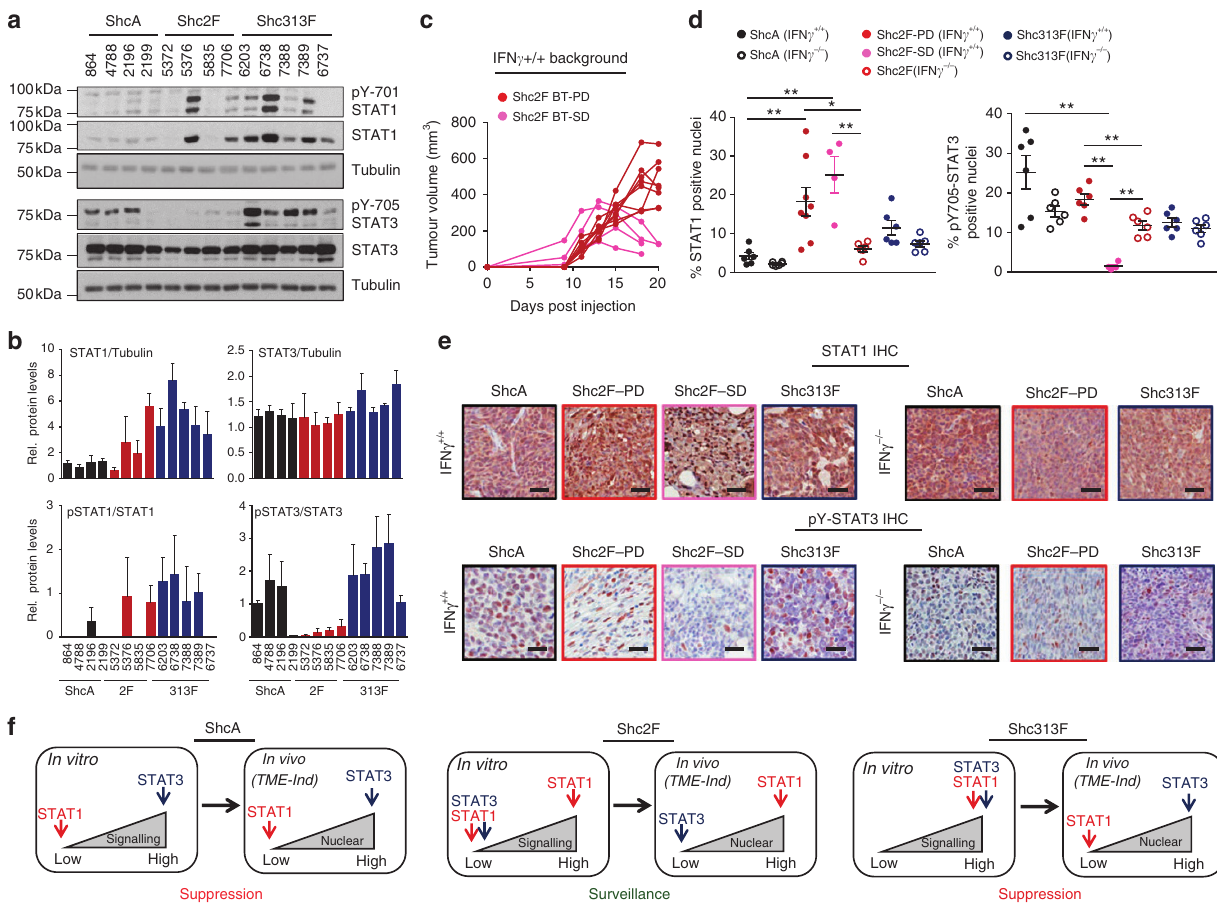
Figure 3 | Distinct ShcA-driven phosphotyrosine signalling networks differentially activate STAT3 and STAT1 signalling in breast cancer cells. ( a ) Immunoblot analysis of total cell lysates from MT/ShcA þ / þ , MT/Shc 2F/2F and MT/Shc 313F/313F breast cancer cells (four to five per genotype) using STAT1, pY701-STAT1, STAT3, pY705-STAT3 and Tubulin antibodies. ( b ) Densitometric quantification of immunoblots using ImageJ software. The data show average fold change in expression levels (as indicated) ± s.d. in the individual cell lines from three independent experiments. ( c ) Growth curves for individual tumour MT/Shc 2F/2F (5372) mammary tumours that emerge in an immunocompetent FVB background (IFN g þ / þ ). Each line describes the tumour volume (mm 3 ) of an individual breast tumour (BT) at the indicated days post injection and is representative of two independent experiments. PD, progressive disease (dark red dot), SD, stable disease (pink dot). ( d ) Immunohistochemical staining of mammary tumours that emerged in IFN g þ / þ or IFN g (cid:2) / (cid:2) mice using STAT1- and pY705-STAT3-specific antibodies ( n ¼ 6–8 tumours per genotype). The mean percentage of STAT1 þ and pY705- STAT3 þ stained nuclei ± s.e.m. is shown. MT/Shc 2F/2F tumours that displayed PD or SD phenotypes were stratified. The data are representative of two independent experiments and significance was analysed by Wilcoxon’s rank-sum test (* P o 0.05 and ** P o 0.01). ( e ) Representative images of STAT1- and pY705-STAT3-stained paraffin-embedded sections. Scale bars, 50 m m. ( f ) Schematic diagram summarizing how altered pY239/240- and pY313-ShcA signalling affect STAT1 and STAT3 activation, both in established cell lines in vitro and in mammary tumours in vivo (induced by the tumour microenvironment, TME). The consequence of the individual ShcA tyrosine phosphorylation sites on emergence of pro- or anti-tumorigenic immune responses is also